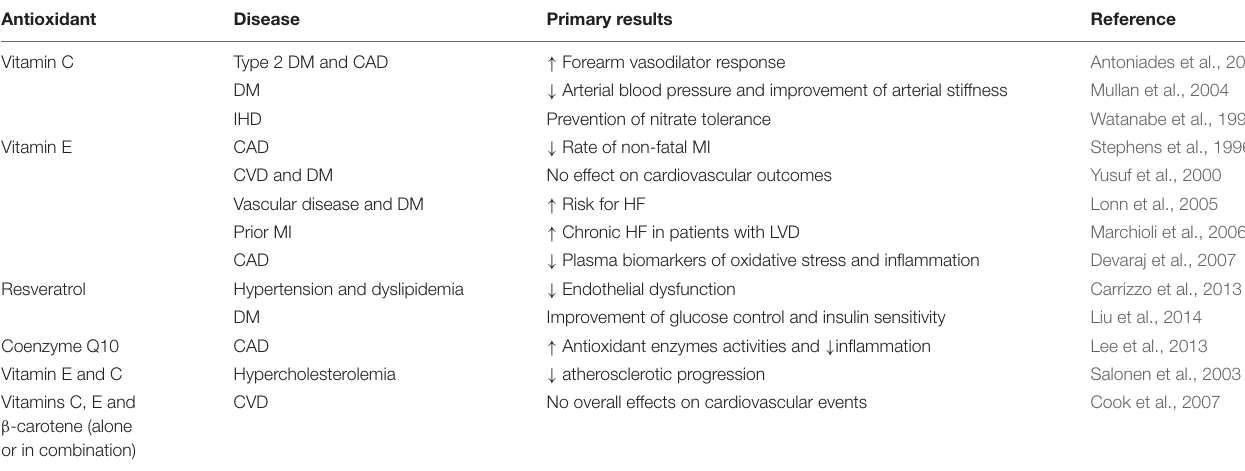
TABLE 1 | Clinical studies performed with the main